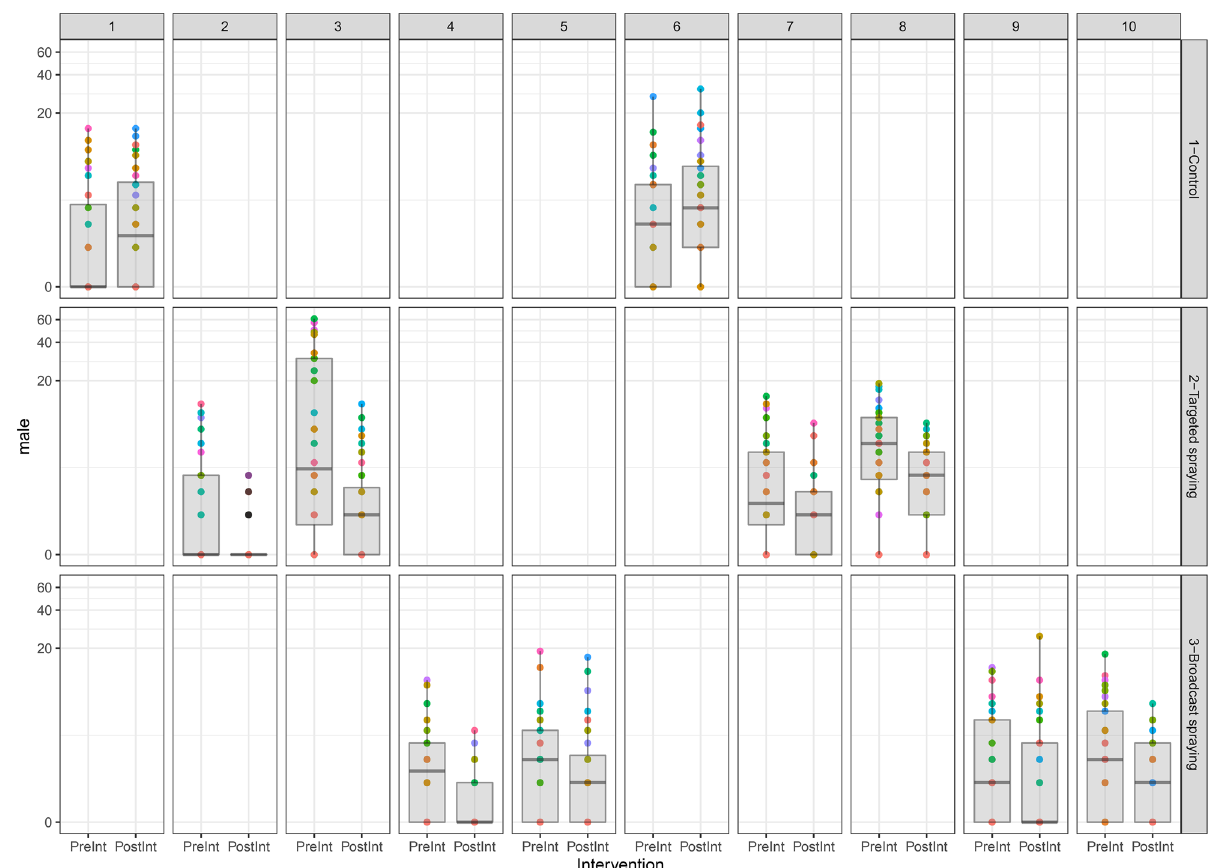
Figure 8. Plot the density of males. In these plots the columns refer to village ID and the rows to intervention type. As each village was only assigned a single intervention each column has only a single filled plot. Each cell shows the density colored by house (points) as well as a boxplot of the distribution of densities over households, both before and after intervention. The y-axis in each plot is given on a log-scale to make the differences in pre- and post-intervention densities more evident. the effect of pre-intervention density had a highly significant negative effect (p-values < 0.001). For change in male density, targeted spraying and broadcast spraying were highly significant with p-value = 0.003 and p-value = 0.001